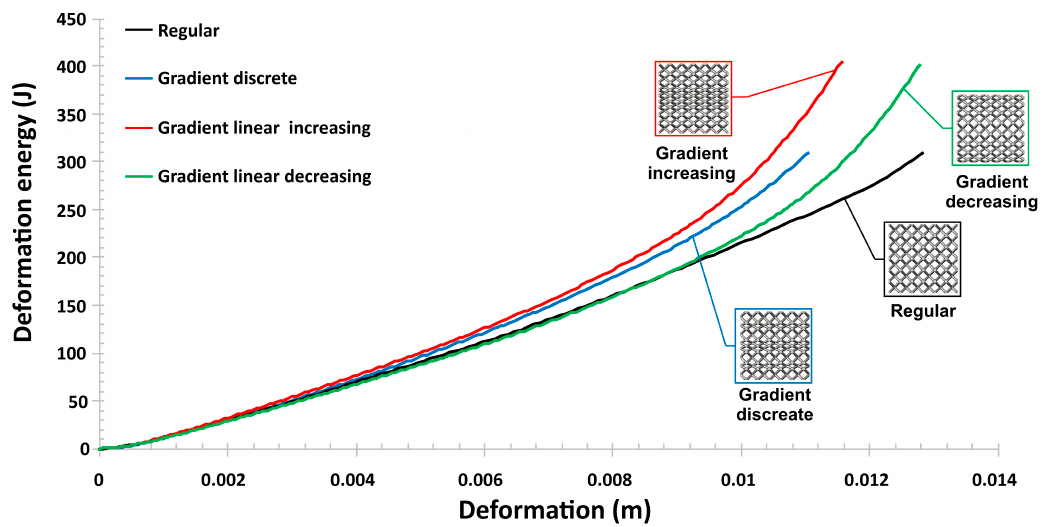
Figure 11. Deformation energy versus displacement history plots registered for various lattice structure specimens.